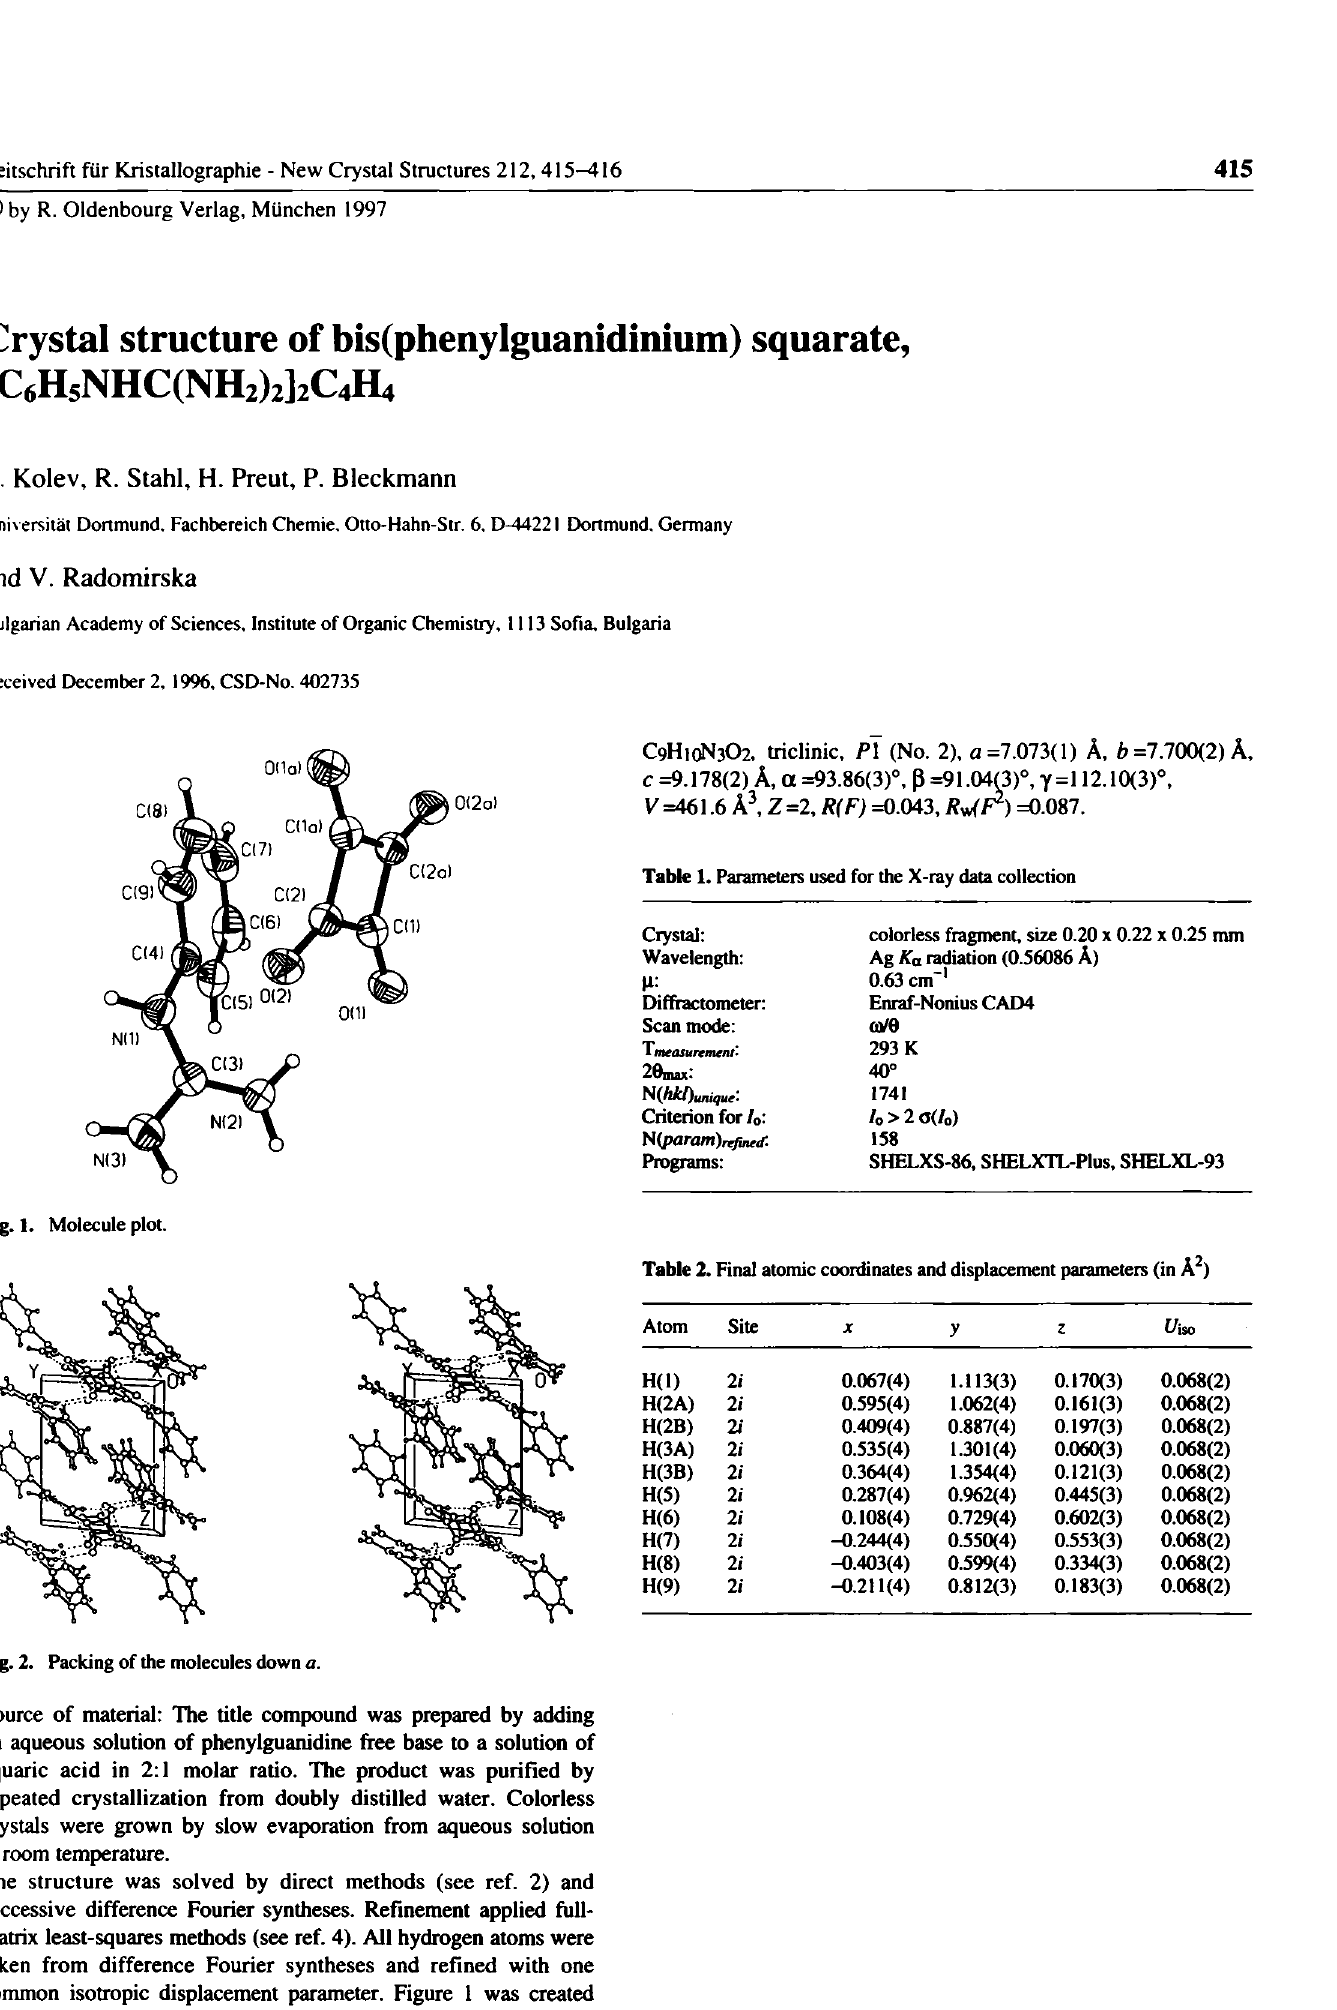
Table 2. Final atomic coordinates and displacement parameters (in Â 2